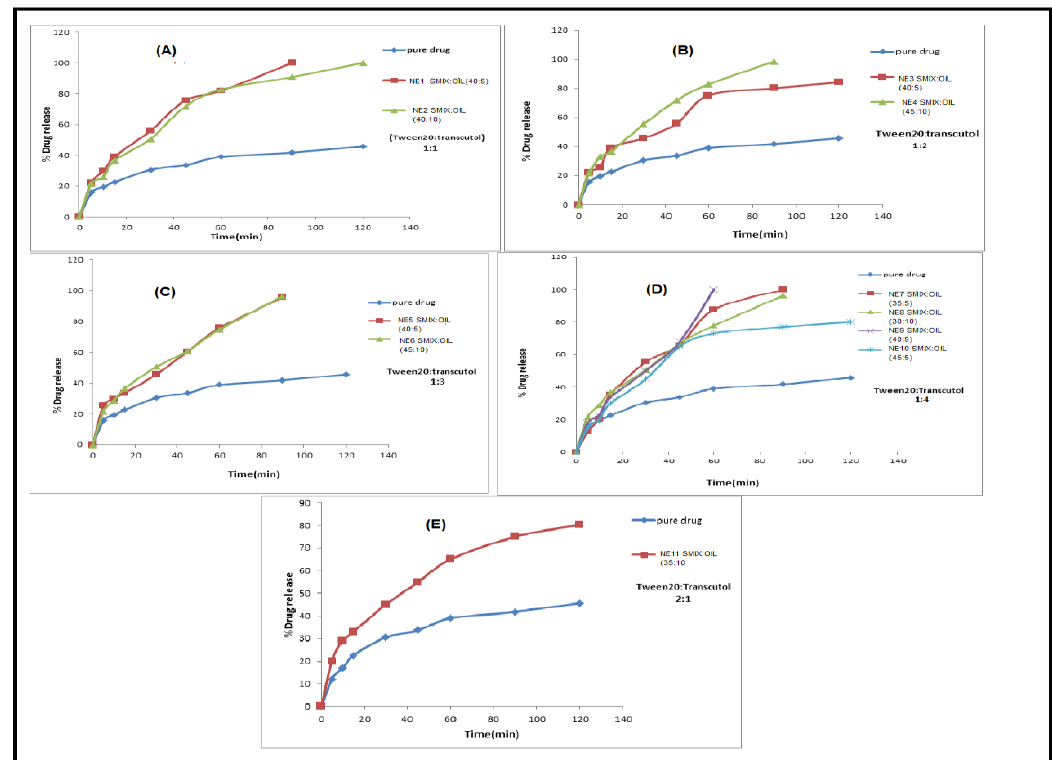
Figure3. Effect of Smix:oil ratio on release profile where (A) release of NE1, NE2 and pure drug (B) release of NE3, NE4and pure drug (C) release of NE5, NE6 and pure drug, (D) release of NE7, NE8 NE9,NE10 and pure drug (E) release of NE11and pure